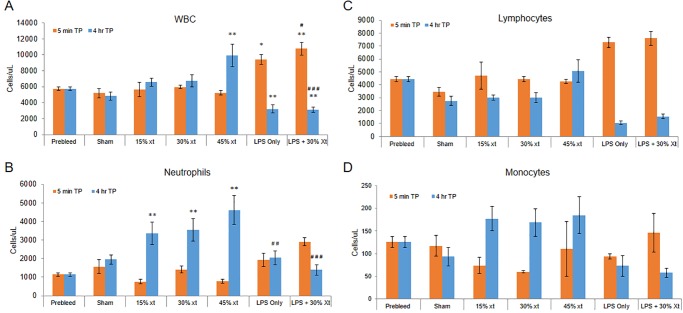
LPS induces leukopenia.Blood was collected from rats before addition of LPS or transfusion (0 min, pre-bleed time point (tp)), (n = 64). Five minutes and 4 hour later, blood was again collected from sham rats (5 min (n = 5) and 4 hours (n = 8)), rats transfused with 15% (5 min (n = 3) and 4 hours (n = 6)), 30% (5 min (n = 3) and 4 hours (n = 9)) or 45% (5 min (n = 3) and 4 hours (n = 6)) human erythrocyte transfusion (xt), LPS only (5 min (n = 4) and 4 hours (n = 10)) or LPS+30% (5 min (n = 3) and 4 hours (n = 13)) transfusion. (A) White blood cells (WBCs). (B) Neutrophils. (C) Monocytes. (D) Lymphocytes. Data are means and standard error of the mean. Statistical analysis was performed using an ANOVA followed by Student t-test. * denotes P ≤ 0.02, ** denotes P ≤ 0.005, respectively, compared to the pre-transfusion control at the corresponding timepoint. # denotes P < 0.05, ## denotes P < 0.01 and ### denotes P < 0.001, respectively, compared to 30% xt at the corresponding timepoint.